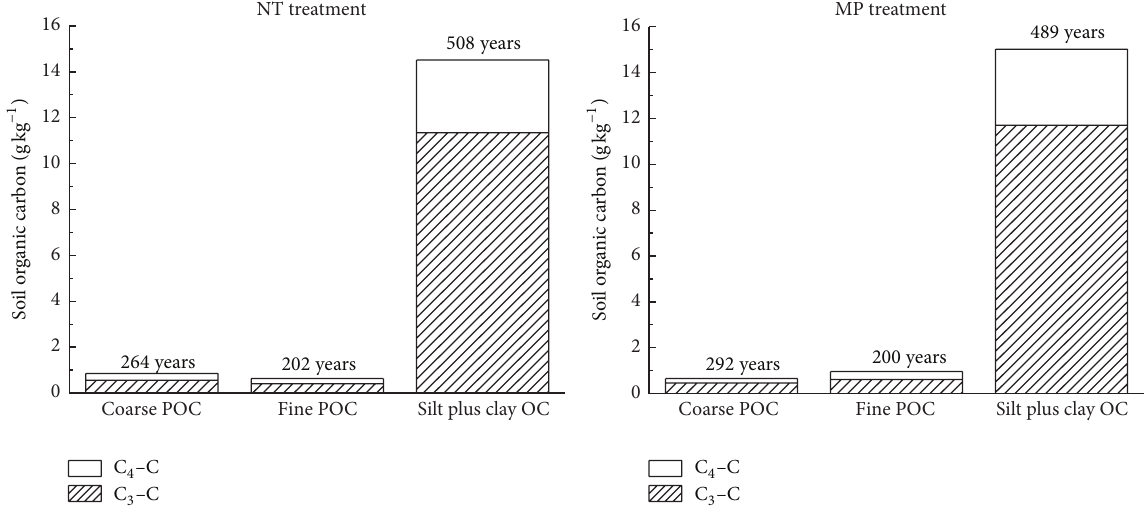
Figure 3: Concentrations of C 3 –C and C 4 –C in different fractions and the mean turnover time of C under tillage